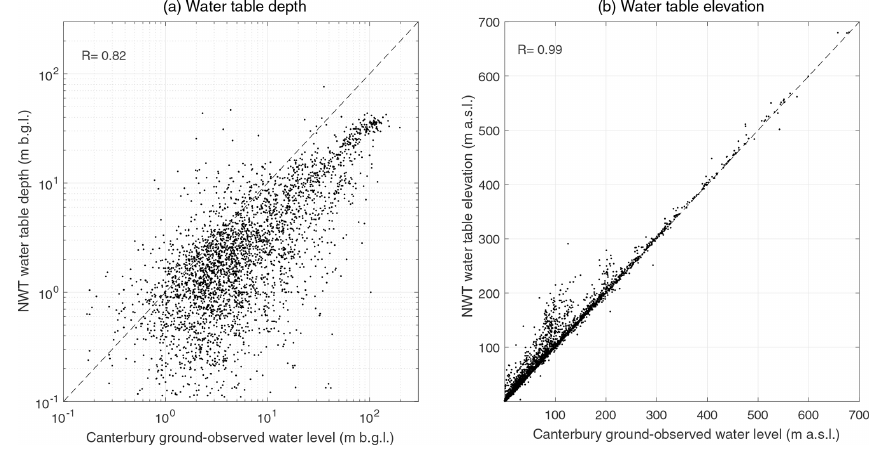
Figure 8. Correlation of NWT water table depth and water table elevation with ground observations in the Canterbury region. The dashed line is the 1 : 1